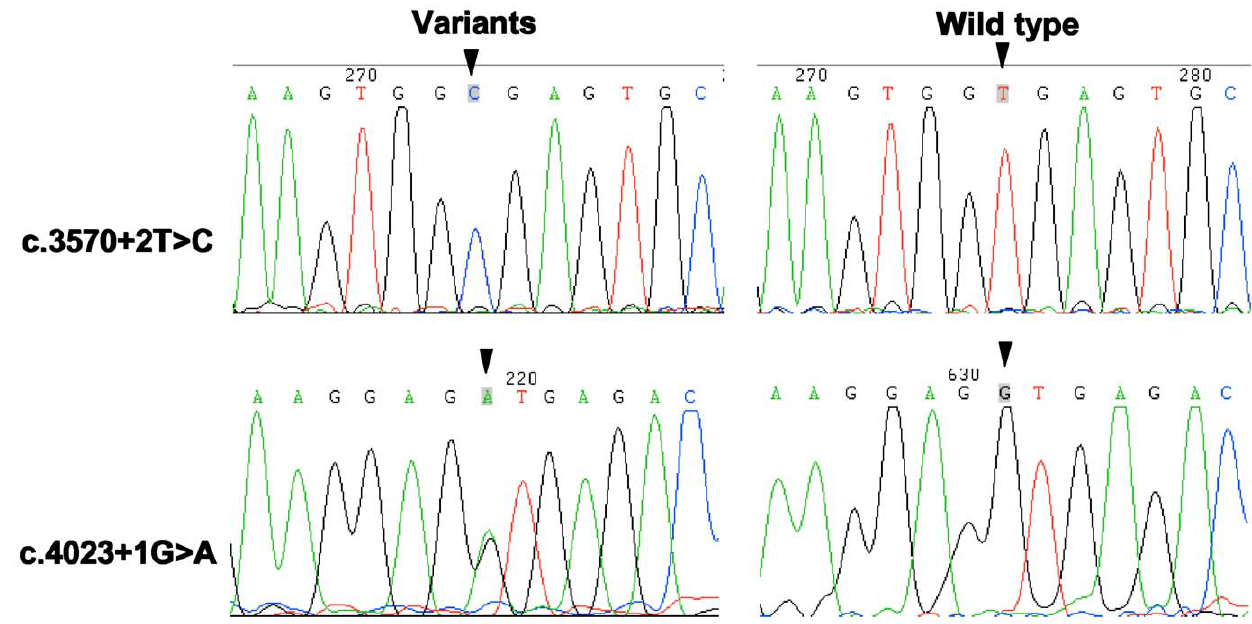
Figure 2. Sequencing chromatograms of novel splice site variants identified in the present work with wild type control. The variants include c.3570 + 2T . C and c.4023 + 1G . A. Corresponding variant locations are arrowed.